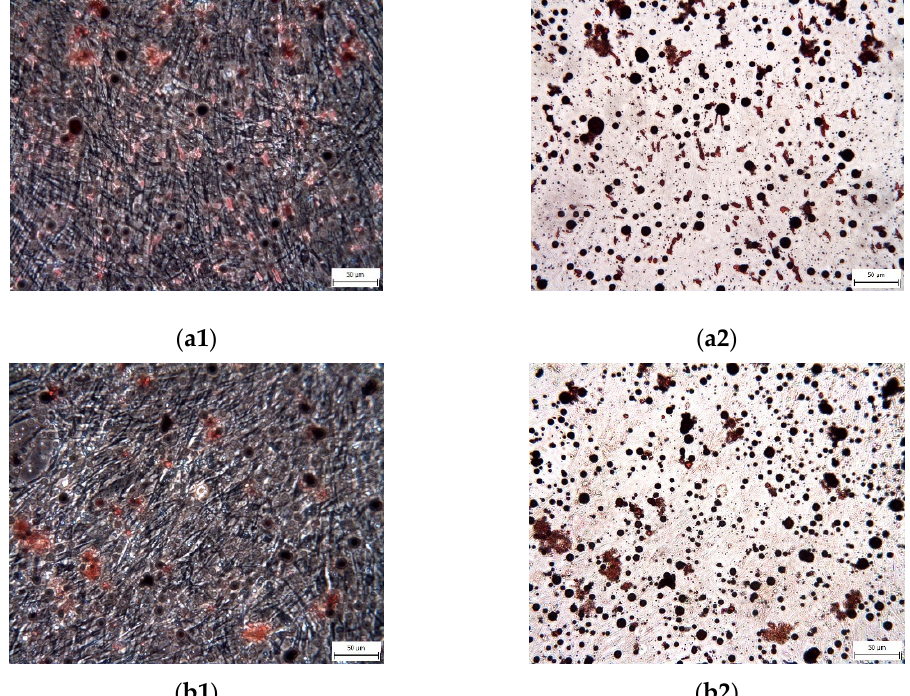
Figure 11. The visualization of adipose vacuoles and droplets in the extracellular matrix of paired DPSC lineages after adipogenic differentiation. After Oil Red staining, the adipose vacuoles are revealed as red areas. Scale bar 50 μ m. ( a1 ) Lineage 5-A (phase contrast optical microscope); ( a2 ) Lineage 5-A (inverted optical microscope); ( b1 ) Lineage 5-B (phase contrast optical microscope); ( b2 ) Lineage 5-B (inverted optical microscope).